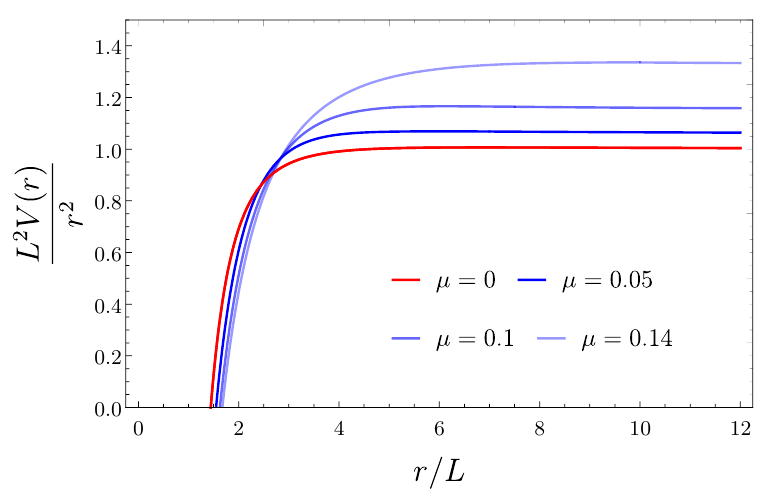
Figure 4 . We plot the metric function V S 2 ( r ) (cid:1) L 2 =r 2 corresponding to Taub-bolt solutions of ECG with n=L = 0 : 1 for several values of (cid:22) . We choose the largest bolt radius r b when there are several solutions for the (cid:12)xed n .